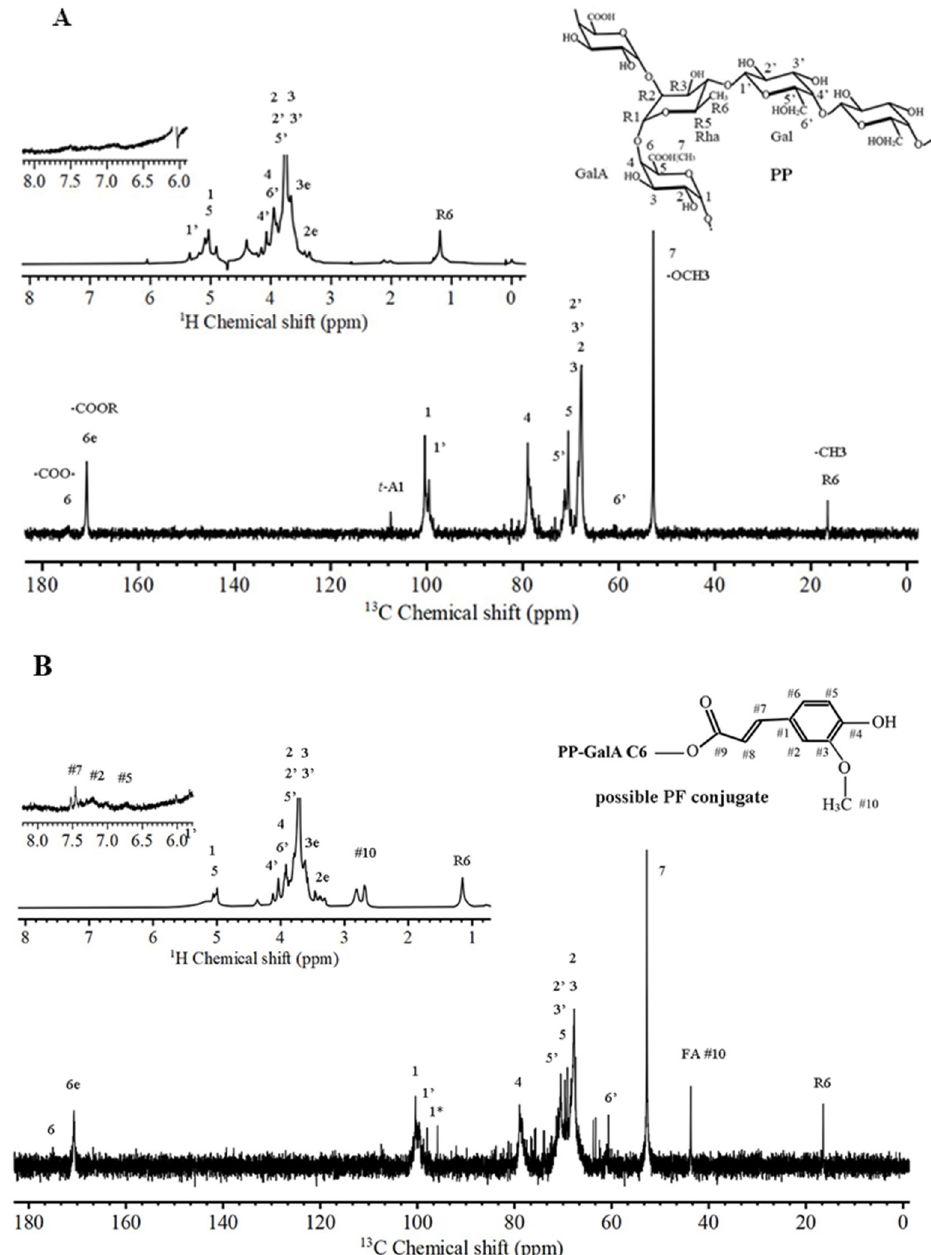
Figure 1. The 176 MHz 13 C and 700 MHz 1 H-decoupled NMR spectra of PP ( A ) and PF ( B ).